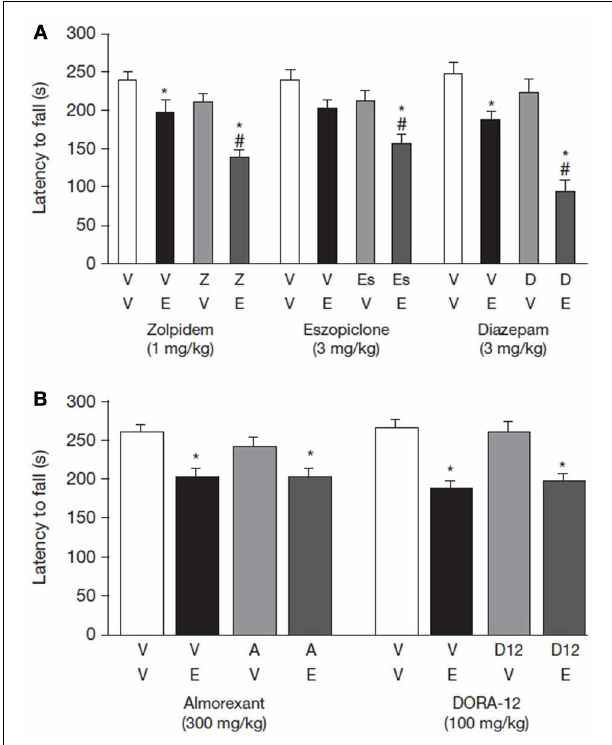
FIGURE 4 | Interaction of ethanol with (A) GABA-A receptor modulators or (B) orexin receptor antagonists on rotarod performance. Effect of GABA-A receptor modulators and orexin receptor antagonists on rotarod performance. Effects of zolpidem, eszopiclone, and diazepam were tested using a minimum effective dose (MED) of ethanol and a MED of test compound based on the results of the dose-response rotarod studies. Effects of almorexant and DORA-12 were tested using doses well-above those required to initiate sleep in combination with the MED of ethanol. Data are shown as mean ± standard error of the mean. ∗ p < 0 . 05 for the level of significance vs. vehicle-vehicle group and # p < 0 . 05 denotes significant difference from the vehicle-ethanol group. Two-Way ANOVA was followed by post-hoc tests (Newman-Keuls multiple comparison tests, n = 7–12). ANOVA, analysis of variance; D, diazepam; E, ethanol; Es, eszopiclone; V, vehicle; Z,